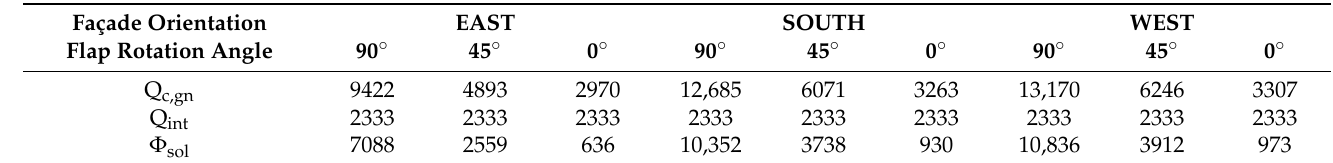
Table 2. Resulting solar gains (Q c,gn ) with shielding modules oriented to East, South and West according to the three rotation angles of the